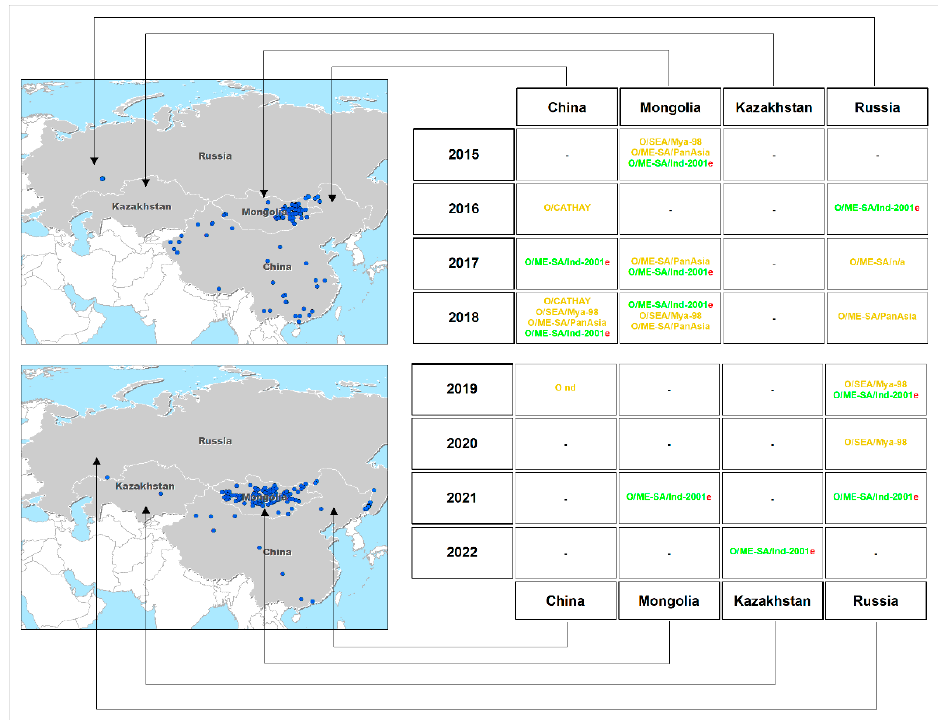
Figure 5. Time course of changes in the range of foot-and-mouth disease outbreaks from 2015 to 2018 and from 2019 to 2022 in Russia, Kazakhstan, Mongolia, and China.